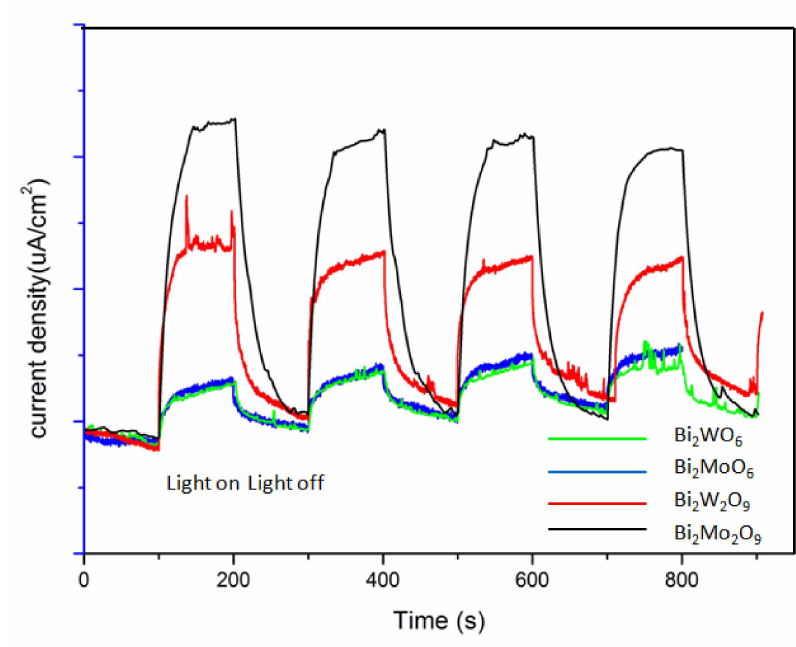
Figure 11. Photocurrent responses of Bi 2 WO 6, Bi 2 W 2 O 9 , Bi 2 MoO 6 and Bi 2 Mo 2 O 9 samples under visible-light irradiation.